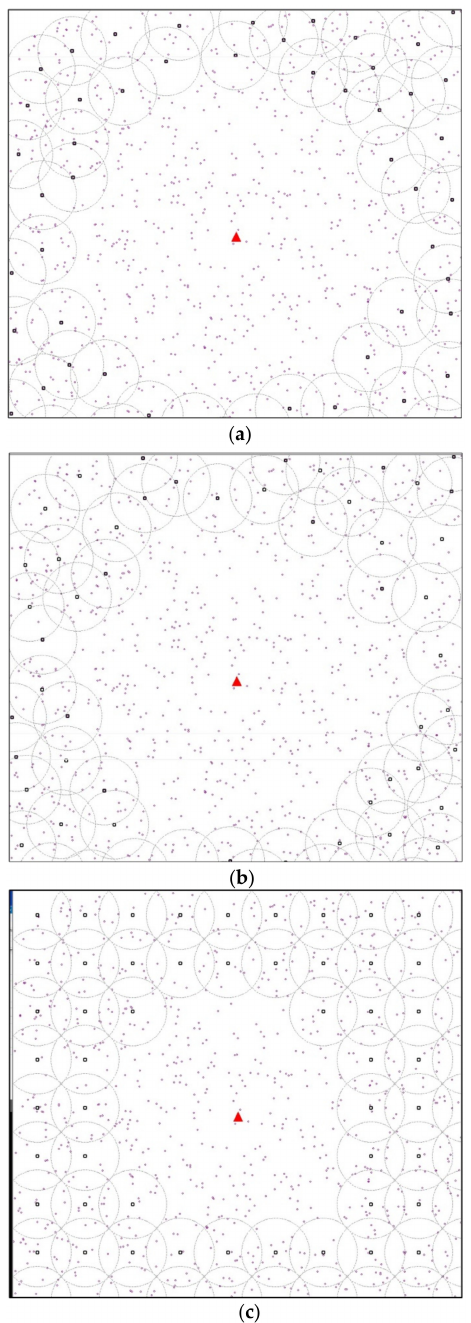
Figure 8. Snapshots for the ( a ) greedy, ( b ) K -mean, and ( c ) static